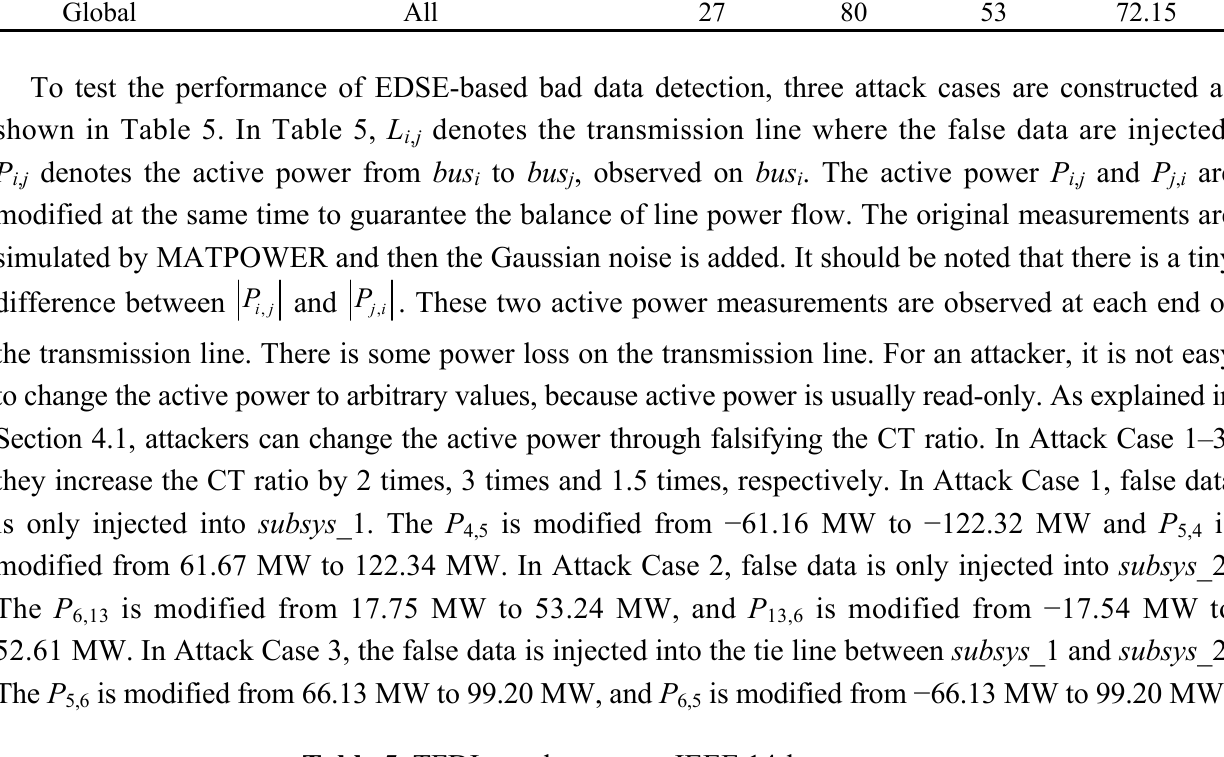
Table 5. TFDI attack cases on IEEE 14-bus